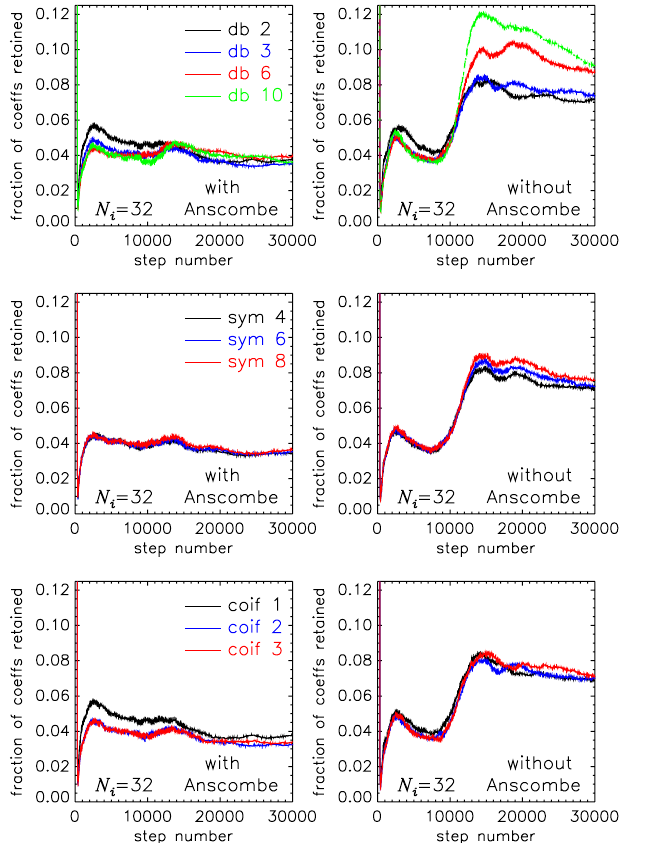
FIG. 19. (Color) Fraction of the wavelet coefficients of the particle distribution retained after thresholding in a fully 3D IMPACT-T with PCG simulations of the NICADD/Fermilab photo- (cid:4) 32 grid, with N (cid:4) 125 000 particles ( N injector on a N i 4 : 58 ). The left column represents the fraction of coefficients retained when the data is Anscombe-transformed, and the right column when the data is not Anscombe-transformed for the 10 different orthogonal wavelet families: Daubechies of order 2, 3, 6, and 10 (top row); symlets of order 4, 6, and 8 (middle row); coiflets of order 1, 2, and 3 (bottom row). Recall, full expansion (cid:4) 32 resolution requires 32 3 (cid:4) 32 768 coefficients, and for N i (cid:4) 64 resolution 64 3 (cid:4) 262 144 coefficients. for N i